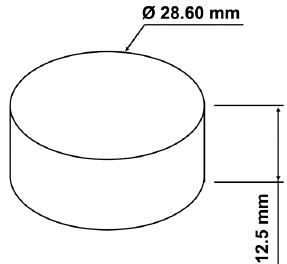
Figure 3. External geometry and dimensions of the compression test samples used, according to ASTM D575 [22] .